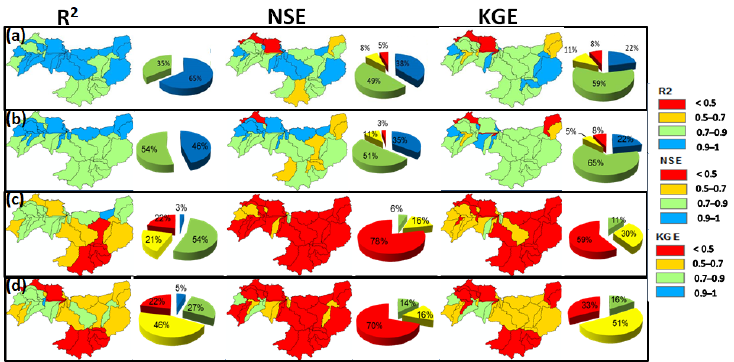
Figure 3. Spatial distribution of performance metrics (R 2 , NSE, and KGE) of SWAT_Hargreaves, when calibrated in 2009 against ETMonitor, GLEAM, WaPOR, and SSEBop ( a , b , c , d ), respectively, in the study area in the Lake Chad Basin.